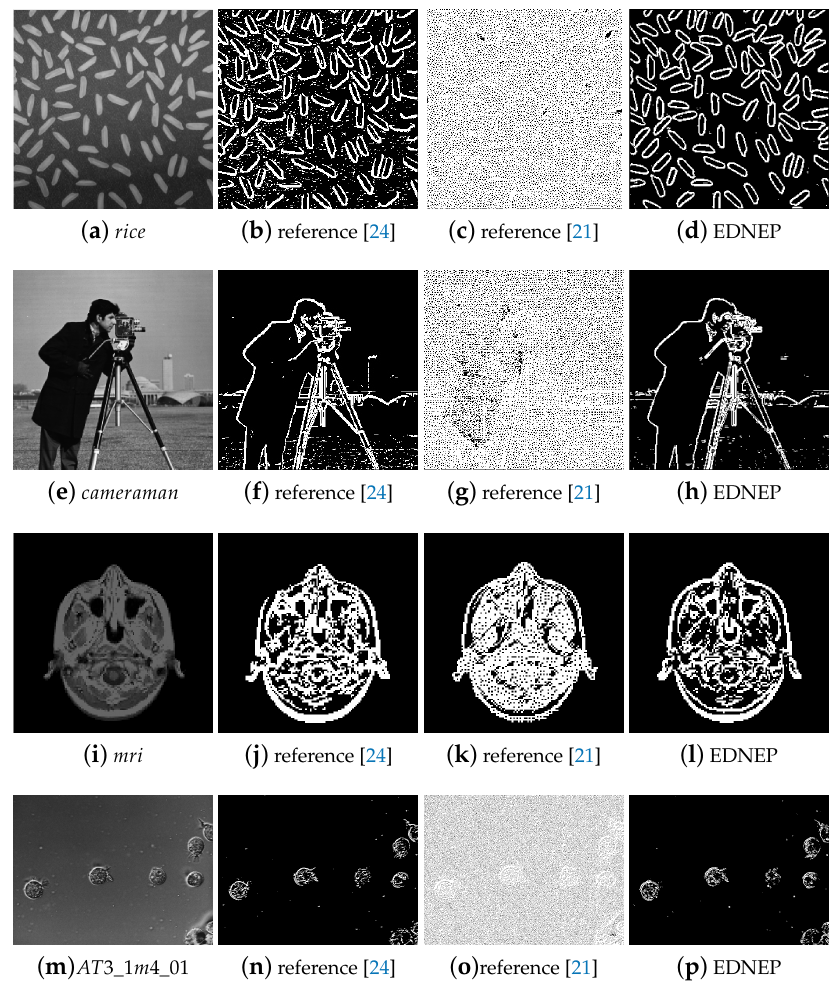
Figure 3. Edge detection results of images with rich texture (the first column: the source gray images; the second to the last column: results by using methods in [21,24] and EDENP respectively).